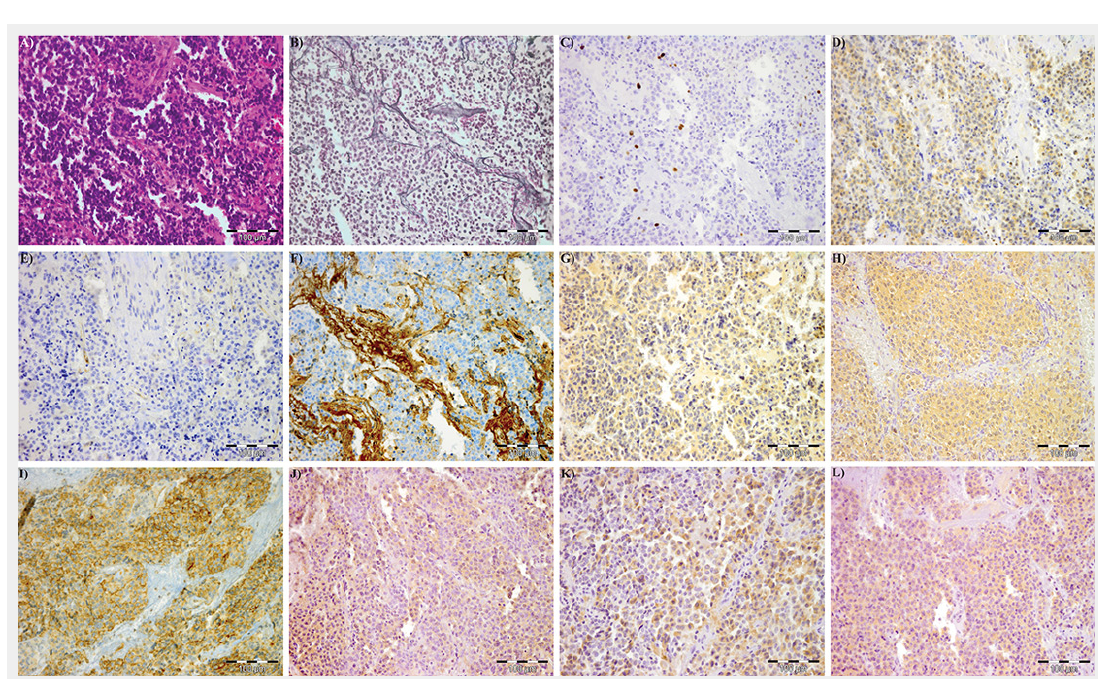
Figure 1 Immunohistochemical expression of the different markers‘ expression in a pituitary adenoma: (A) hematoxilin-eosin, (B) reticulin, (C) MIB-1 (Ki-67), (D) Eg5, (E) VEGFR-2, (F) vWF, (G) IL-8, (H) SSTR-1, (I) SSTR-2, (J) SSTR-3, (K) SSTR-4, (L) SSTR-5. Eg5 = kinesin spindle protein; IL-8 = interleukin-8; SSTR = somatostatin receptor; VEGFR-2 = vascular endothelial growth factor receptor-2; vWF = von Willebrand-factor